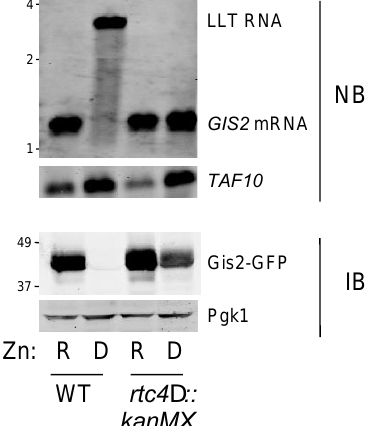
Figure 4. The r tc4 ∆ ::kanMX allele disrupts regulation of the adjacent GIS2 gene. Wild-type (BY4741) and isogenic r tc4 ∆ ::kanMX mutant cells bearing a GIS2 ::GFP allele were grown in zinc-replete (R, LZM + 100 µ M ZnCl 2 ) or deficient (D, LZM + 1 µ M ZnCl 2 ) media prior to immunoblot (IB) and Northern blot (NB) analysis. Pgk1 was used as a loading control for immunoblotting and TAF10 mRNA was used as the control for Northern blotting. The location of size markers is indicated on the left side of each panel in kb (top panel) or kDa (bottom panel).